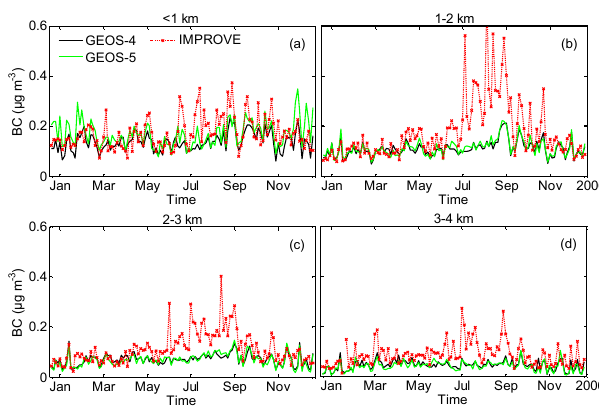
Figure 8. (a-d) Same as Figure 4, but from simulations driven by GEOS-4 (black line) and GEOS-5 (green line) reanalysis data and with 8-day GFEDv2 emissions. Fig. 8. (a–d) Same as Fig. 4, but from simulations driven by GEOS- 4 (black line) and GEOS-5 (green line) reanalysis data and with GFEDv2 8-day